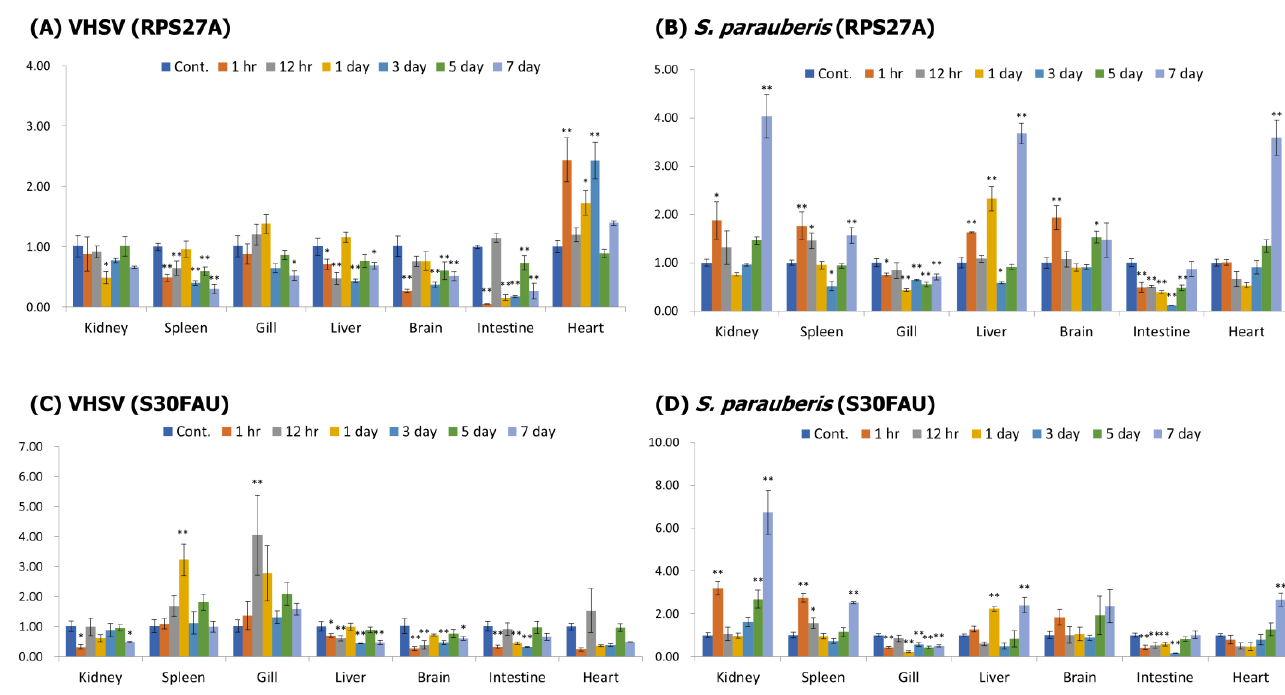
Figure 5. Gene expression of RPS27A ( A , B ) and S30FAU ( C , D ) in the kidney, spleen, gill, liver, brain, intestine, and heart after infection with VHSV and S. parauberis . Levels of RPS27A and S30FAU transcripts were quantified relative to that of EF-1 α levels. Data are presented as the mean ± SD from three independent cDNA samples with three replicates for each sample. Asterisks represent significant differences compared to the control (PBS) group by ANOVA (* p < 0.05 and ** p < 0.01).